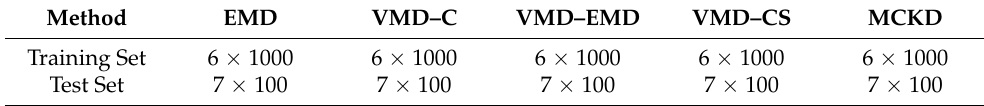
Table 1. The central frequencies of IMF components corresponding to different K